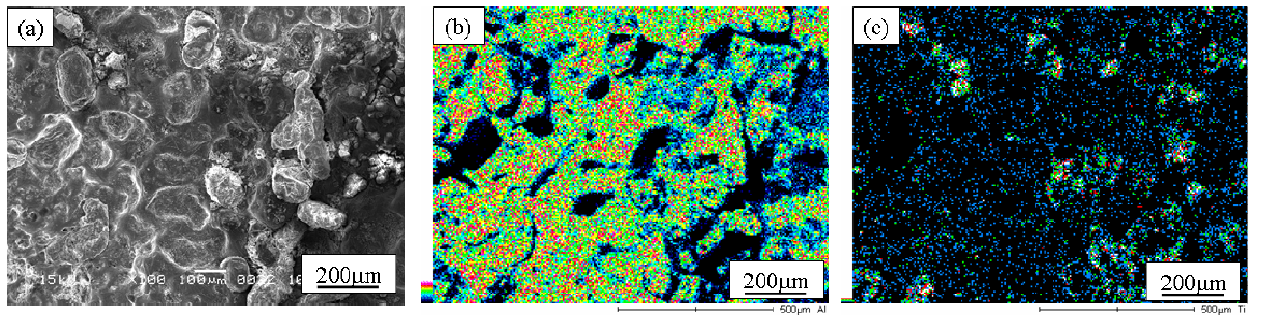
Figure 15. Distributions of Ti concentration in Al/TiO